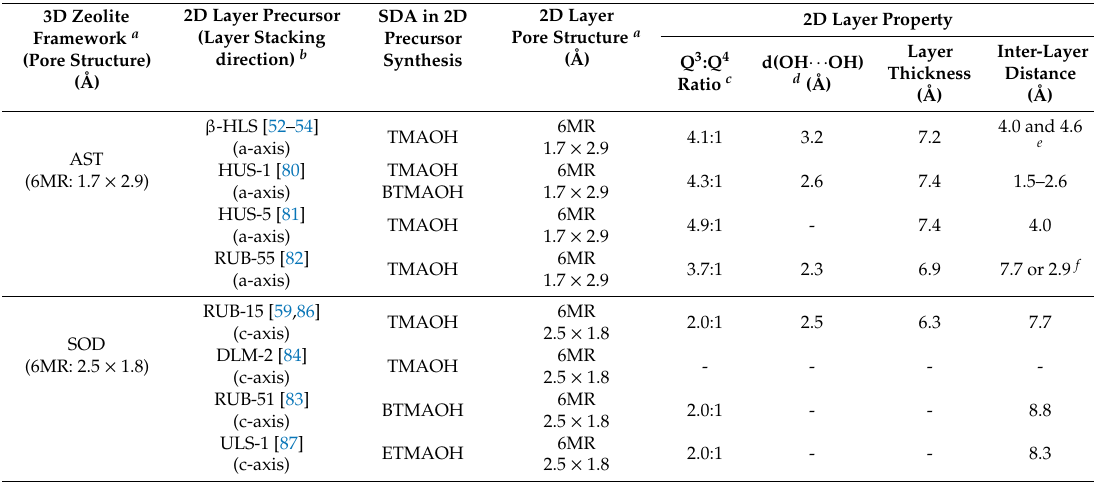
Table 1. Structural properties of 2D layered precursors and their related 3D (6-MR) zeolites. 3D Zeolite Framework